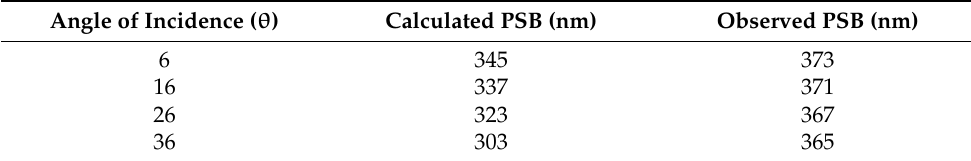
Table 3. Variation in the position of the PSB with angle of